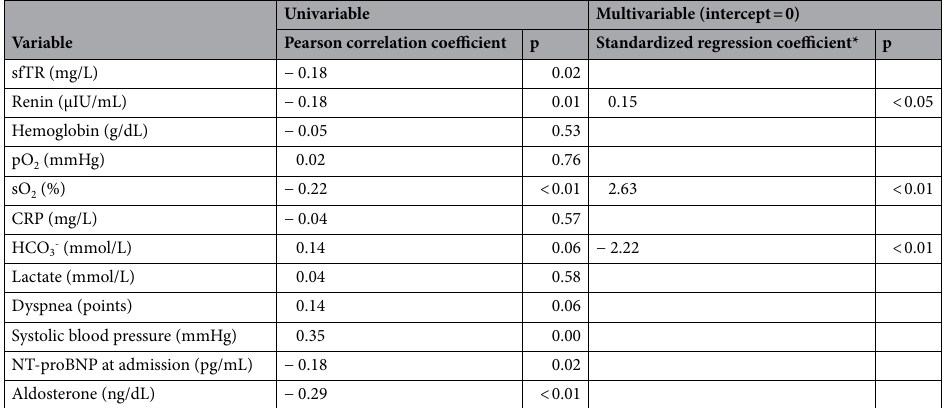
Table 3. Clinical and laboratory determinants of hyperventilation (pCO 2 ≤ 30 mmHg on admission). sFTR soluble transferrin receptor, pO 2 partial pressure of oxygen, sO 2 oxygen saturation, CRP C-reactive protein, HCO